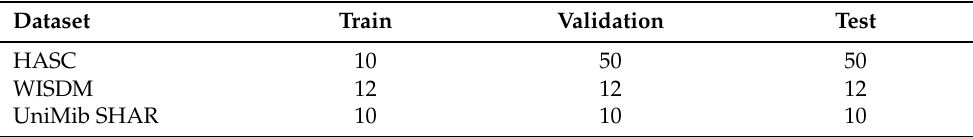
Table 1. Details of the number of subjects in each dataset in the hold-out method.